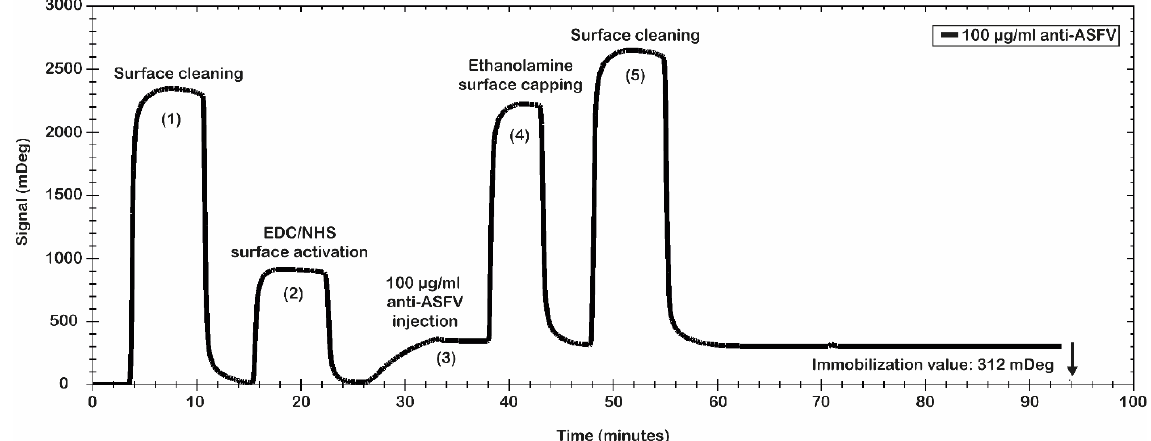
Figure 3. Anti-ASFV immobilization procedure. Sensorgram of amine coupling immobilization procedure. Main steps are shown: (1) cleaning, (2) activation with EDC/NHS mixture, (3) injection and bound of polyclonal antibodies, (4) ester deactivations by ethanolamine capping, and (5) cleaning. Polyclonal anti-ASFVs were immobilized at 312 mDeg.